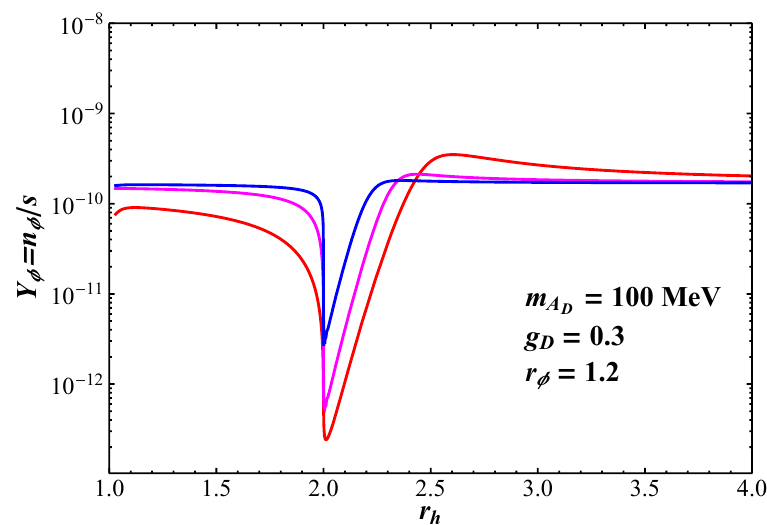
Figure 7. The DM yield Y φ for b = 1 (Red), b = 0 . 2 (Magenta), and b = 0 . 05 (Blue) as a function of r h , scaled by the yield when the effects of the dark Higgs are omitted ( b = 0 ). Here, we have chosen r φ = 1 . 2 , g D = 0 . 3 , and m A = 100 D